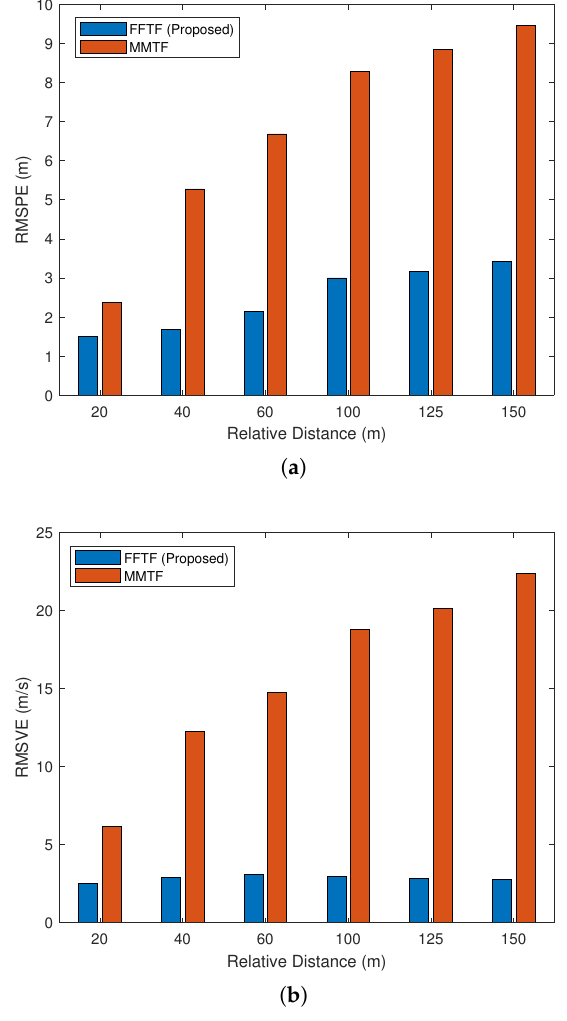
Figure 6. Simulation results under various relative distances: ( a ) RMSPE; ( b )